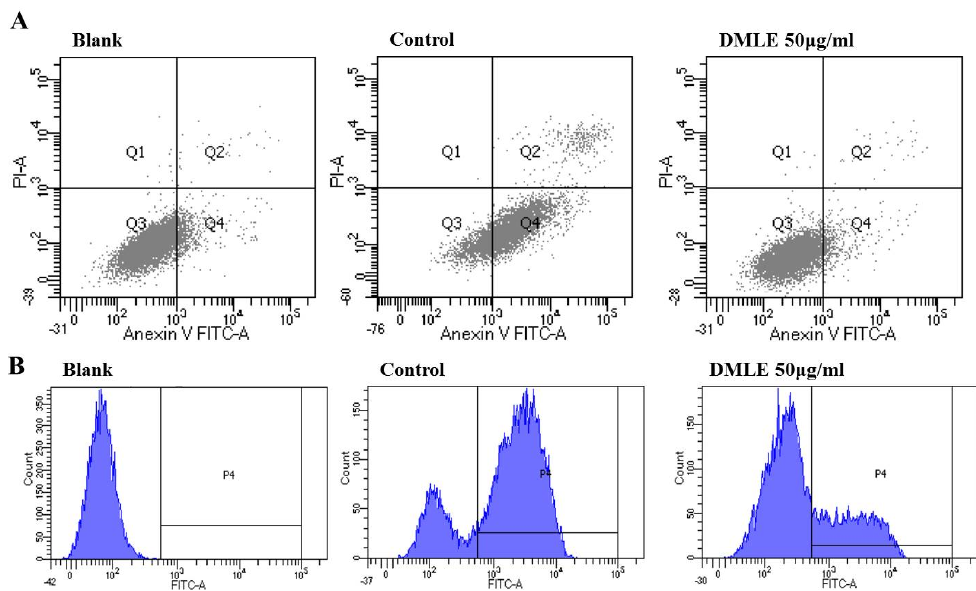
Figure 5. Effect of D. morbifera leaf extracts (DMLE) on EtOH induced HepG2 cell apoptosis and ROS production. ( A ) Apoptosis quantification of annexin V-FITC positive cells in the top (PI negative) and bottom (PI positive) right quadrant were indicated. ( B ) ROS induction in HepG2 cells was either treated with different concentrations of DMLE before EtOH treatment. ROS generation was measured by a flow cytometer. Cells were treated with different concentrations of DMLE for 1 h, and then exposed to ethanol (400 μ M) for 24 h.